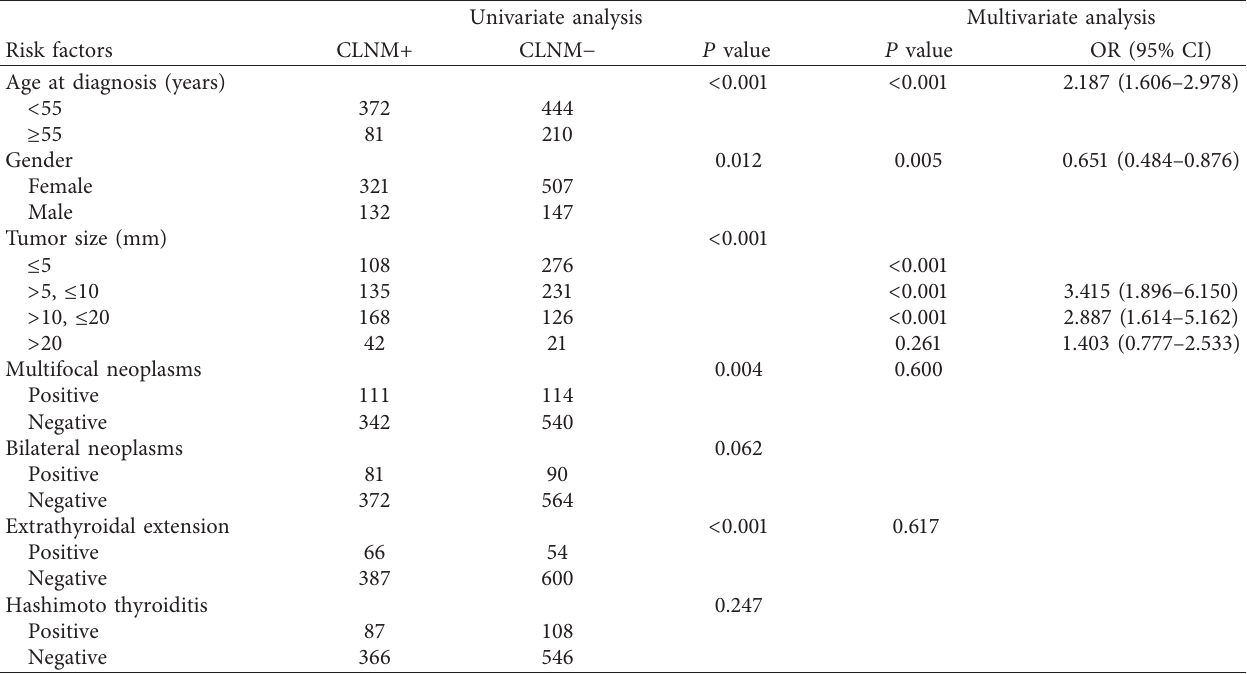
Table 4: Univariable and multivariate analysis for